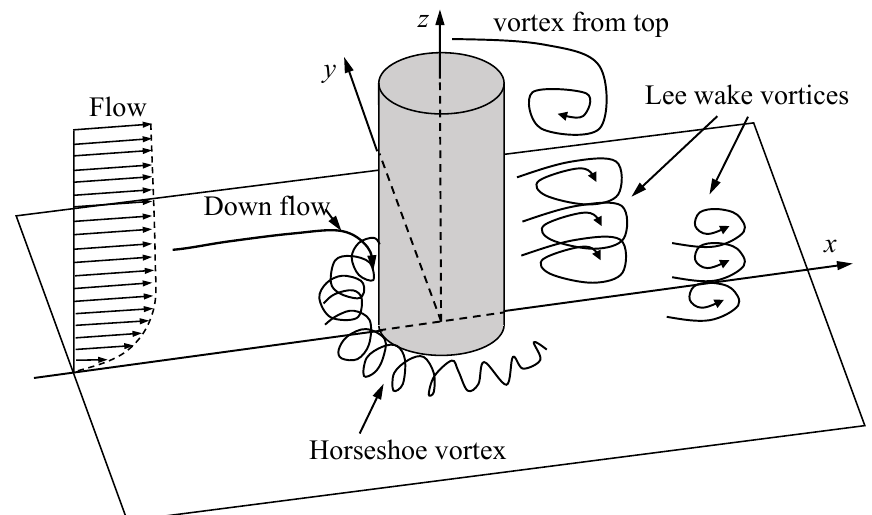
Figure 1. Definition sketch of flow around a submerged vertical cylinder.